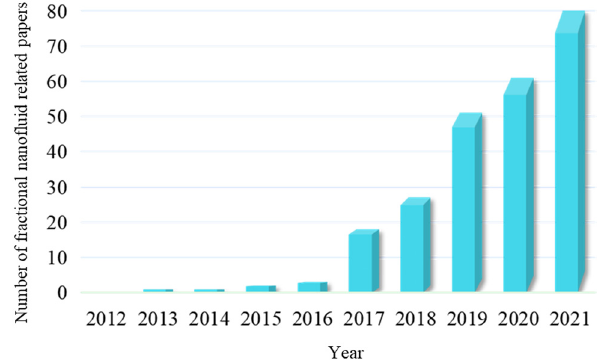
Figure 2: Number of papers on fractional nano fl uids published reports by Web of